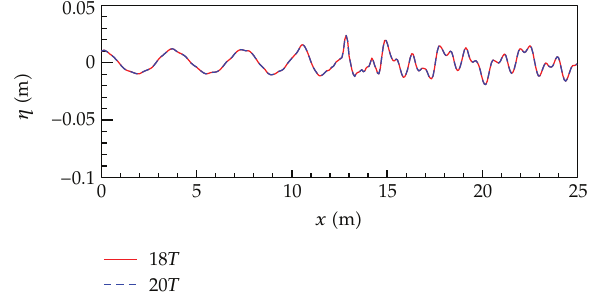
Figure 3: Wave profile along the plane of symmetry at t (cid:9) 18 T and 20